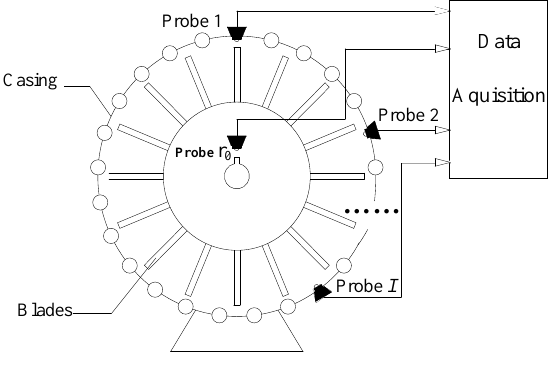
Figure 1. Blade tip timing system.